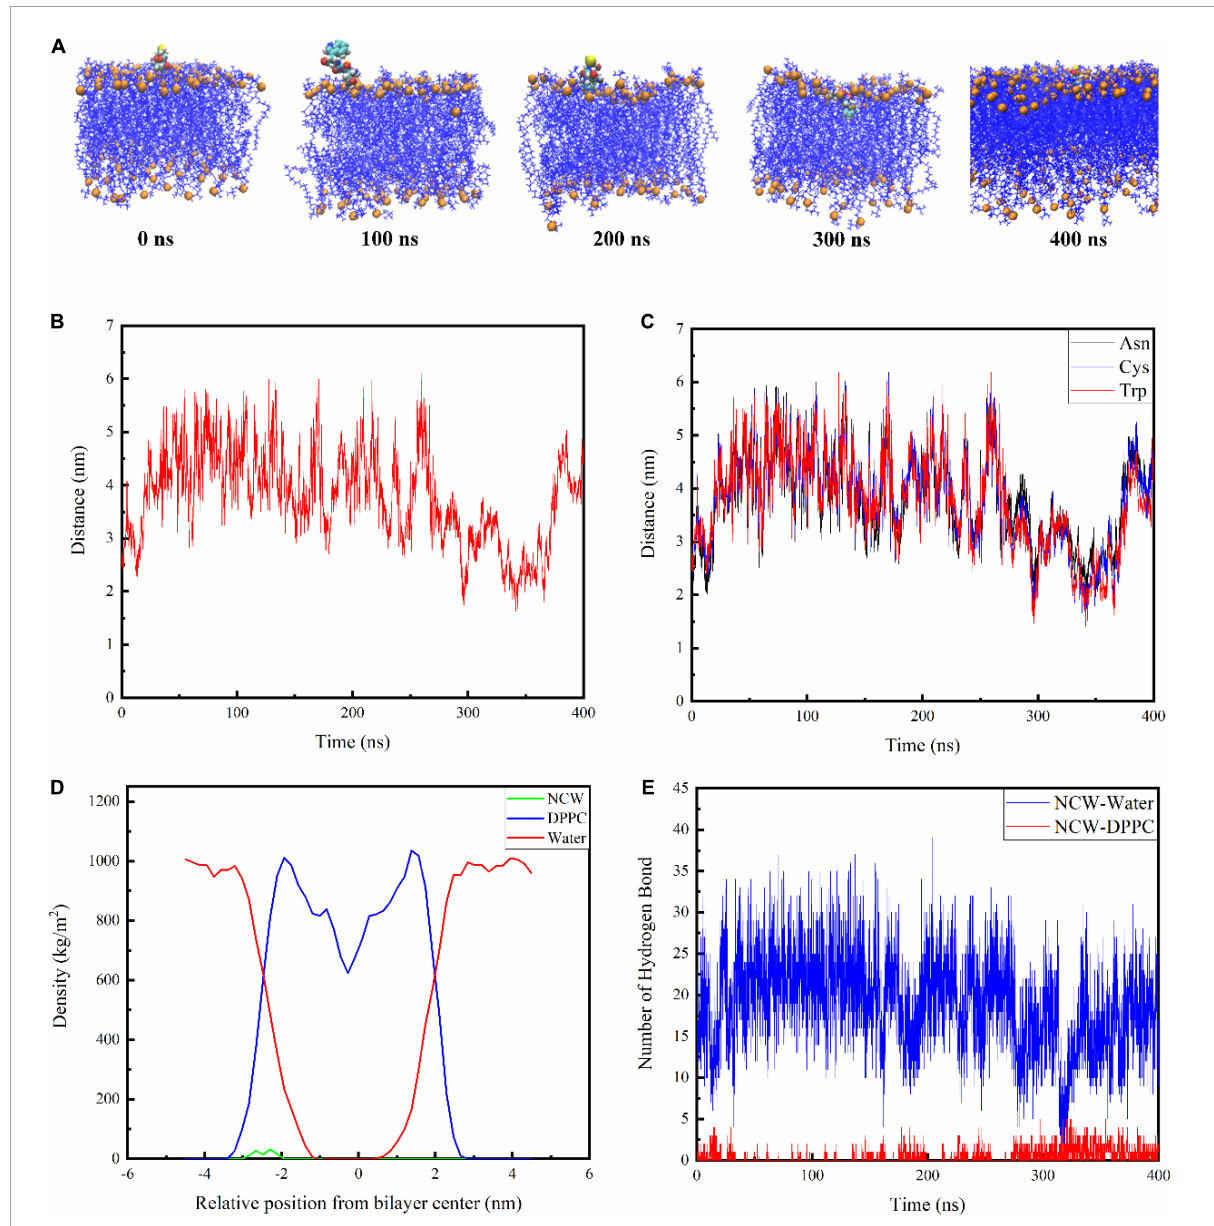
FIGURE2 Interactions of tripeptide NCW with the cellular membrane. Snapshots from 400 ns simulation of the complexes formed between the tripeptide NCW and DPPC (A) . The center of mass for tripeptide NCW and membrane center distance as a function of time (B) . The corresponding mass center distance for each residue of tripeptide NCW with membrane center (C) . Mass density profile of tripeptide NCW, water, and DPPC lipid bilayer along the membrane normal averaged from 200 to 400 ns dynamic simulation study (D) . The hydrogen bond number formed between tripeptide NCW and membrane, and peptides with water during the simulation (E)